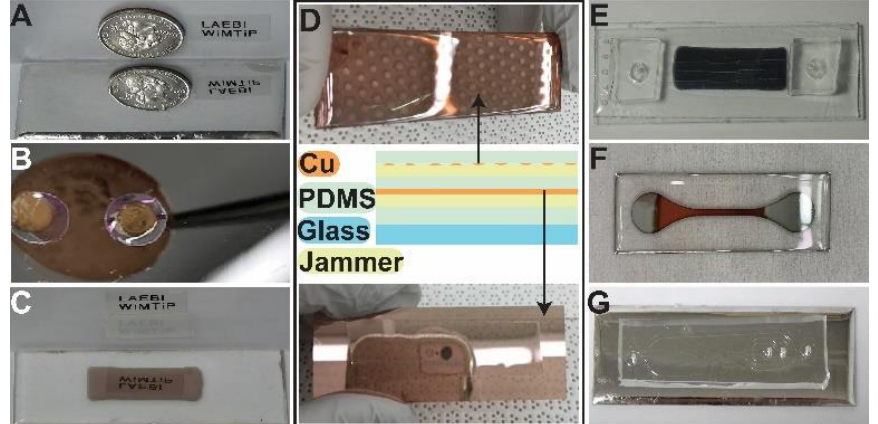
Figure 2. Gallery of various samples and devices using WiMTiP composite: top encasing polymer (25 μm ) – middle metal film (50 nm) – bottom polymer substrate (1.5 mm). Jammer (yellow in sketch) is present only between bottom polymer and film. ( A ) PDMS – Al – PDMS on a glass slide, ( B ) PDMS – Ti – PDMS on a polyurethane sheet, ( C ) PDMS – Cr – PDMS nano-strain sensor on a glass slide where rectangular Cr film was sputtered with a shadow mask. ( D ) A double-layer WiMTiP over a glass slide: PDMS (1 mm) – Cu (50 nm: polka dots) – PDMS (25 μ m)-Cu (50 nm film)-PDMS (50 μ m). Top: encased polka dot Cu film; Middle: Schematics of double-layer WiMTiP; Bottom: encased uniform Cu film. ( E ) A microfluidic channel with a 50 nm pdms-Al -WiMTiP for measuring viscoelasticity of cancer cell membrane. ( F ) A pdms-Ti -WiMTiP for studying the conductivity of a nm film under large strain. ( G ) eChip microfluidics with flow focusing and nano-strain sensor for quantifying adhesion force of a live biofilm in shear flow.